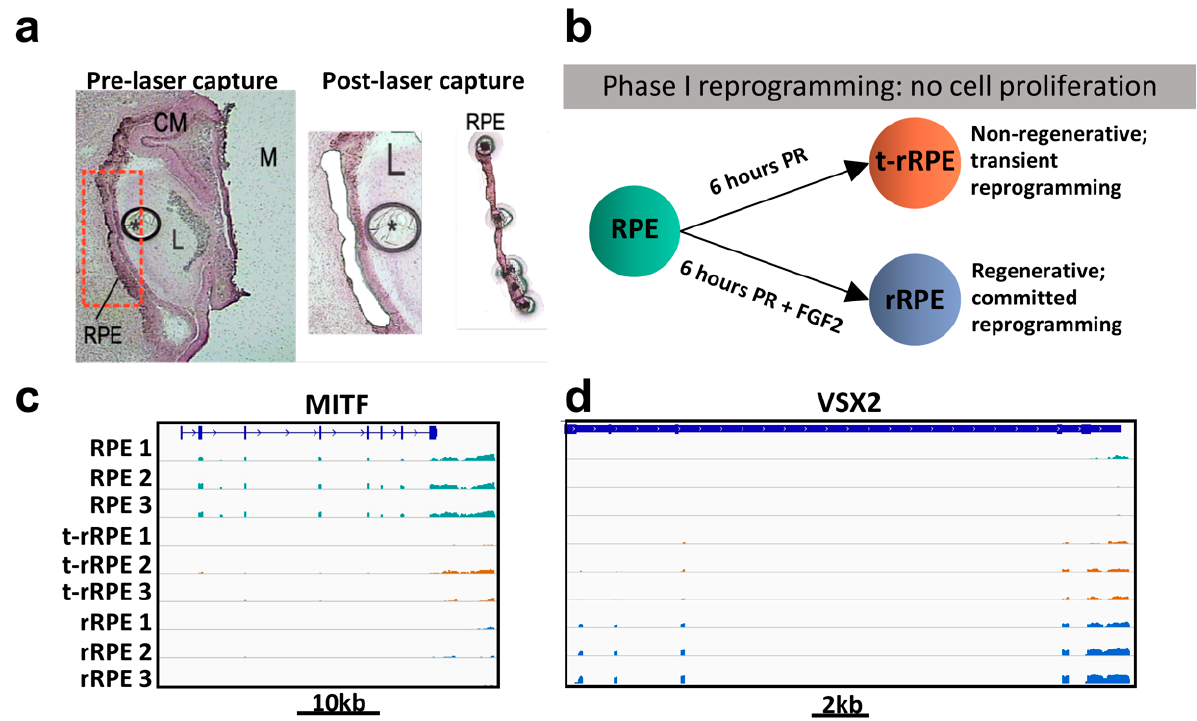
Figure 1. RNA-seq experimental design, quality control, and data are summarized . ( a ) RPE was isolated using LCM. ( b ) RNA-seq was performed on intact RPE, transiently reprogrammed RPE (t-rRPE) 6h post-retinectomy (PR), and reprogrammed RPE (rRPE) 6h PR in the presence of an FGF2-soaked bead. ( c,d ) Snapshot of Integrative Genomics Viewer genome browser of RPE-specific gene MITF and retinal progenitor gene VSX2 , respectively. The scale bar below shows the genomic distance in base pairs. Labels: CM: Ciliary Margin; L: Lens; RPE: Retinal pigment epithelium; *: FGF2-soaked